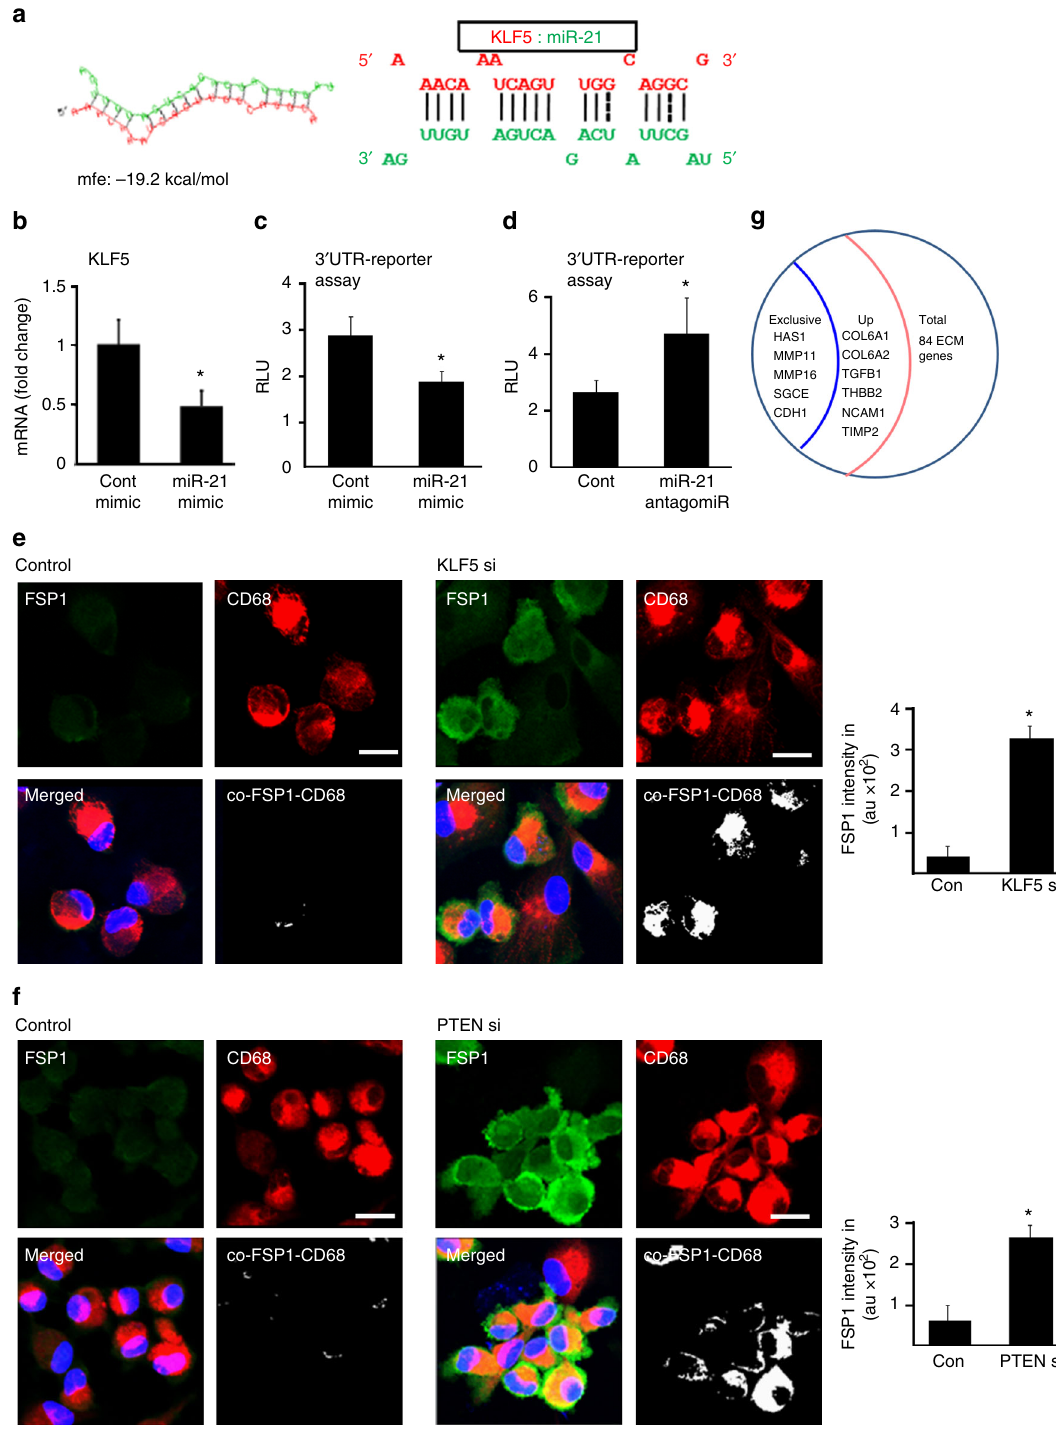
Fig. 6 miR-21 targets KLF5 and PTEN for wound macrophage to fi broblast-like cell conversion. a miR-21 predicted to target the KLF5 3 ′ UTR position 348 – 368 using RNAHybrid prediction algorithm. b qRT-PCR analysis of KLF5 expression in miR-21 transfected M1 polarized human MDM, n = 5, Student ’ s t test p < 0.05. c , d KLF5- 3 ′ UTR luciferase reporter assay transfected with either ( c ) miR-21 mimic or ( d ) miR-21 antago-miR in M1-polarized human MDM, n = PCR array for human extracellular matrix and adhesion molecules. The expression of HAS1, MMP11, MMP16, SGCE, and CDH1 were present only in the double knockdown (PTEN si and KLF si) cells while it was not detected in the control-transfected group. Expressions of a total of six genes were speci fi cally upregulated in the PTEN si/KLF5 si-treated cells as comparted to the control si-treated cells, n = 4, Student ’ s t test p <